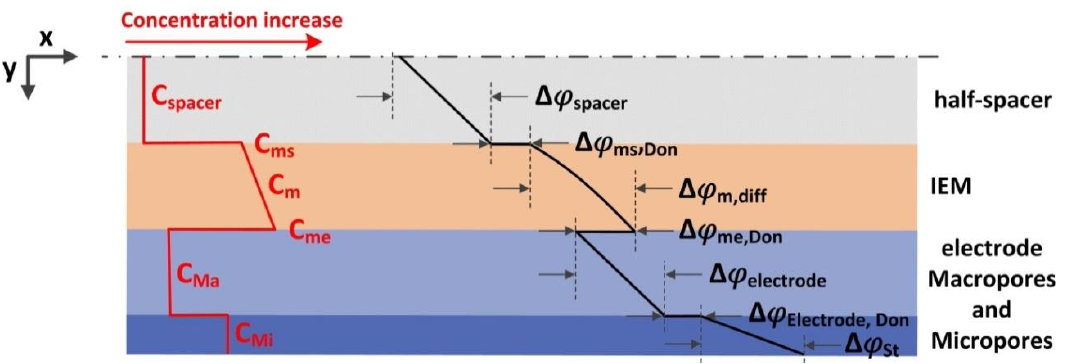
Figure 7. Schematic illustration of counter-ion concentration ( C ) and dimensionless voltage ( φ ) distribution over a half-cell within an MCDI stack. Subscripts ms, m, me, Ma, and Mi stand for membrane/spacer interface, membrane phase, membrane/electrode interface, carbon macropores, and micropores, respectively. Reproduced with permission from [103], copyright Elsvier, 2017.